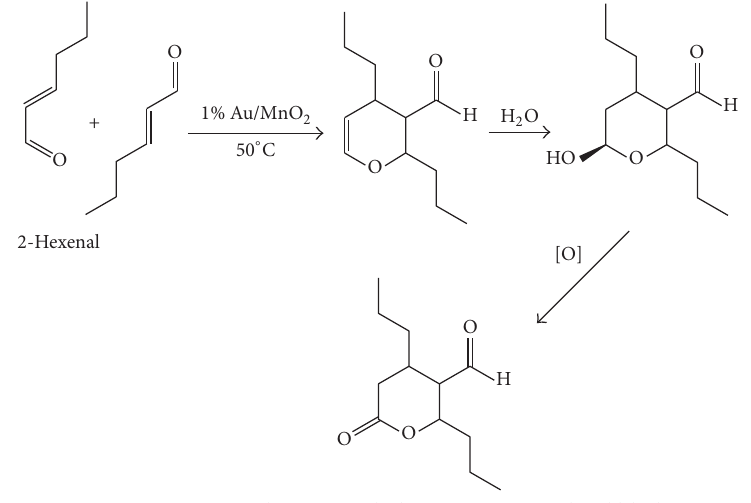
Figure 5: Diels-Alder formation of product 4,6-dipropyl-3,4,5,6-tetrahydropyran-2-one-5-carboxaldehyde from oxidation product 2-